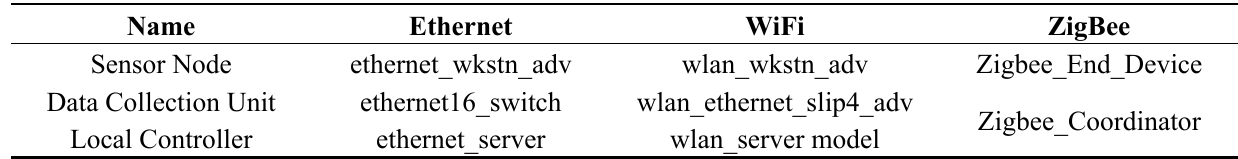
Figure 7. Communication network architecture of small-scale renewable energy systems for a smart-house in OPNET. ( a ) Ethernet; ( b ) WiFi; (c) ZigBee. Table 8. Node model used in OPNET